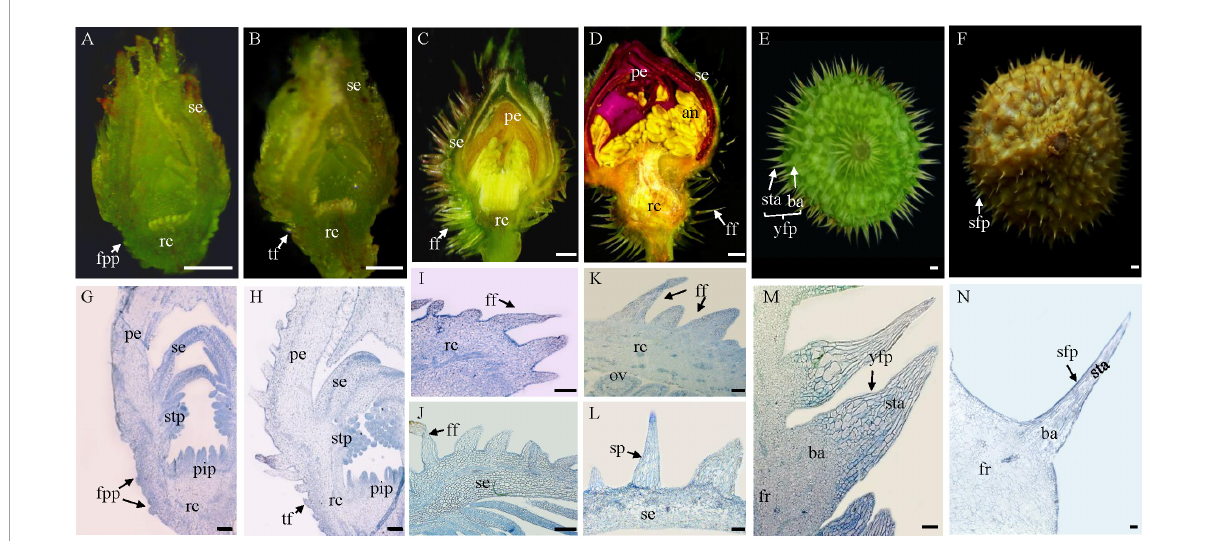
FIGURE1 Origination and development of fruit prickles in R. roxburghii. (A–F) The macroscopic depiction of the development of fruit prickles during flower development (A–D) and fruit development (E,F) . Anatomy of fruit prickle primordium (fpp) (G) , triangular-shaped fpp (H) , flagelliform fpp of sepal (I,J) , flagelliform fpp of the receptacle (K,L) , young fruit prickle on 20 DAP fruit (M) , and sharp fruit prickle on 80 DAP fruit (N) . se, sepal; rc, receptacle; pe, petal; stp, stamen primordium; pip, pistil primordium; fpp, fruit prickle primordium; tf, triangular fpp; ff, flagelliform fpp; ov, ovule; an, anther; fr, fruit; sta, stalk; ba, base; yfp, young fruit prickle; sfp, sharp fruit prickle. (A–F) , bar = 500 µ m; (G–N) , bar = 100 µ